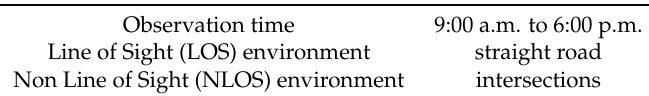
Table 1. Measurement